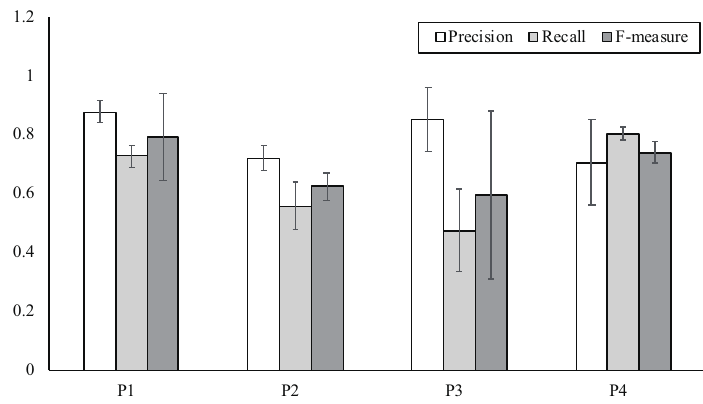
Figure 10. Agreement between the system and the human analysis (C1, C2 and C3). The data from the toys was filtered using the T